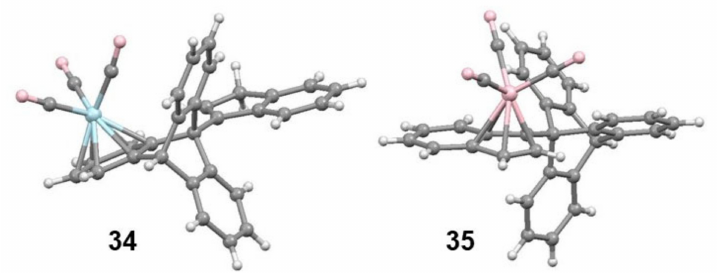
Figure 15. Structures of [ η 6 -9-(3-indenyl)-1,2,3,4,4a,9a-triptycene]tricarbonyl-chromium, 34 , and